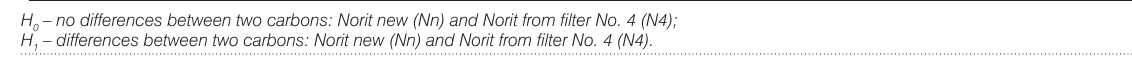
Table 8. Mean values of physicochemical parameters of raw water, after sand filtration, before and after carbon